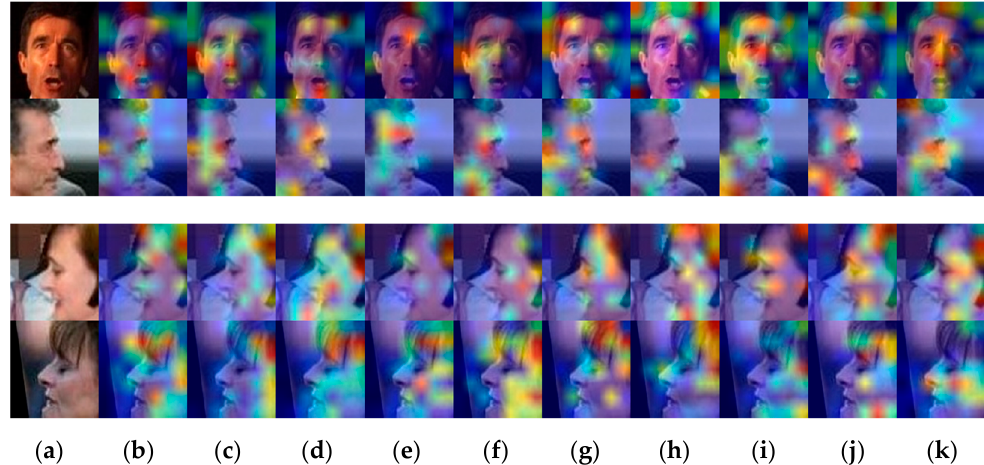
Figure 10. Two random face image pairs from CPLFW [42] dataset. The original image pairs are shown in ( a ). Corresponding Grad-CAM visualization for the baseline pair is depicted in ( b ), and other a tt ention modules are depicted from ( c – j ), while the proposed a tt ention module of this work is illustrated in ( k ), all arranged column-wise from left to right. ( a ) Original face image pairs; ( b ) ConvFaceNeXt; ( c ) SE; ( d ) ECA; ( e ) CBAM; ( f ) ECBAM; ( g ) CA; ( h ) SCA; ( i ) TA; ( j ) DAA; ( k ) LCAM.